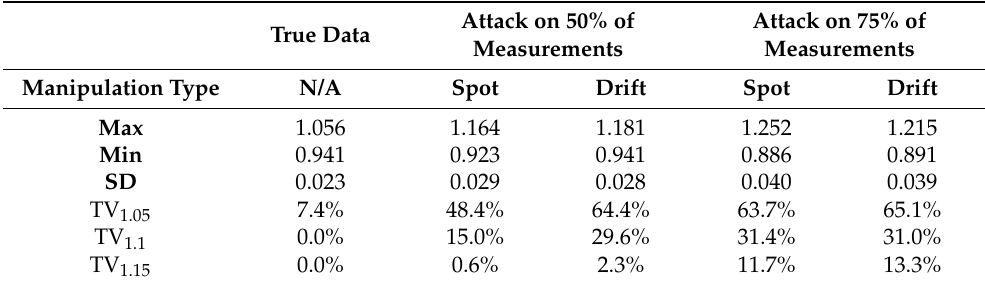
Table 2. Main results considering a combination of anomalies and percentage of falsified measure-